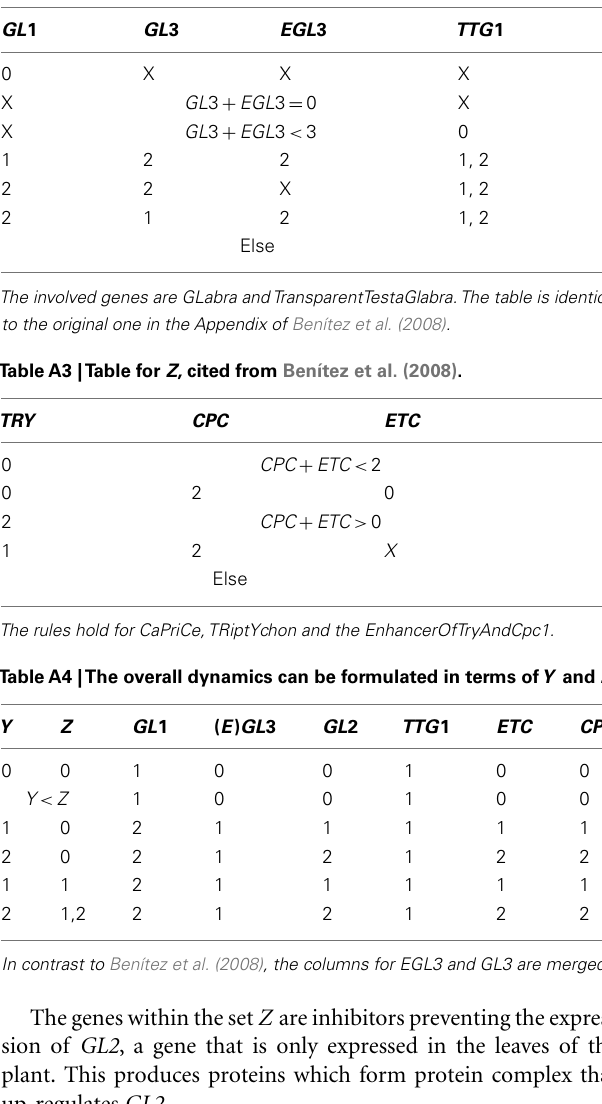
the node can take any